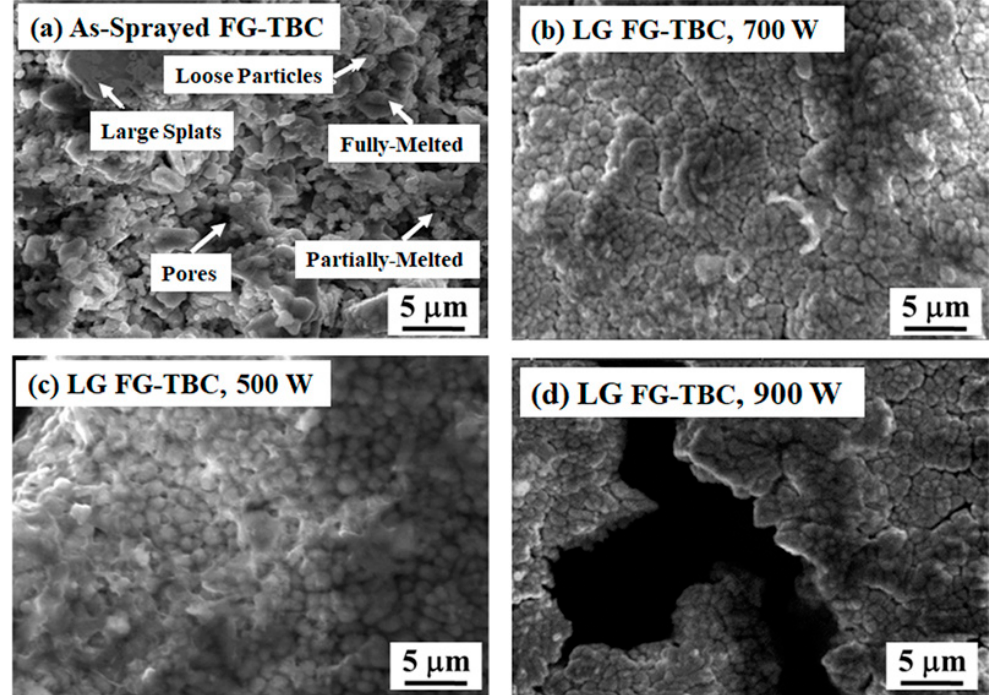
Figure 4. SEM images: ( a ) as-sprayed FG-TBC. Laser-glazed (LG) surfaces obtained using laser power setting of ( b ) 700 W, ( c ) 500 W and ( d ) 900 W.